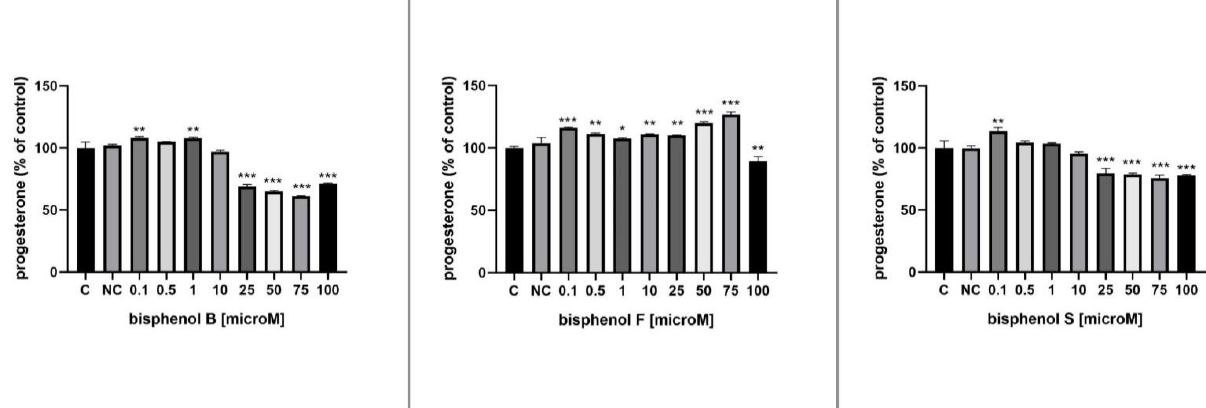
Figure 5. The impact of bisphenol B, F, and S on H295R cells progesterone secretion in vitro. Abbreviations: C—control group, NC—negative control. The mean ( ± SEM) optical density percent of the control (untreated) and treated (bisphenol) groups is represented by each bar. The data were collected from three separate experiments. Between the control and experimental groups, the significance levels were established at *** ( p < 0.001), ** ( p < 0.01), and * ( p < 0.05).